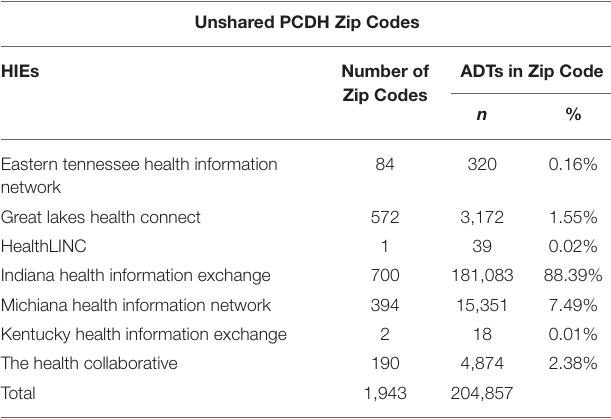
TABLE 1 | Unshared zip code counts and ADT messages within that zip code in the